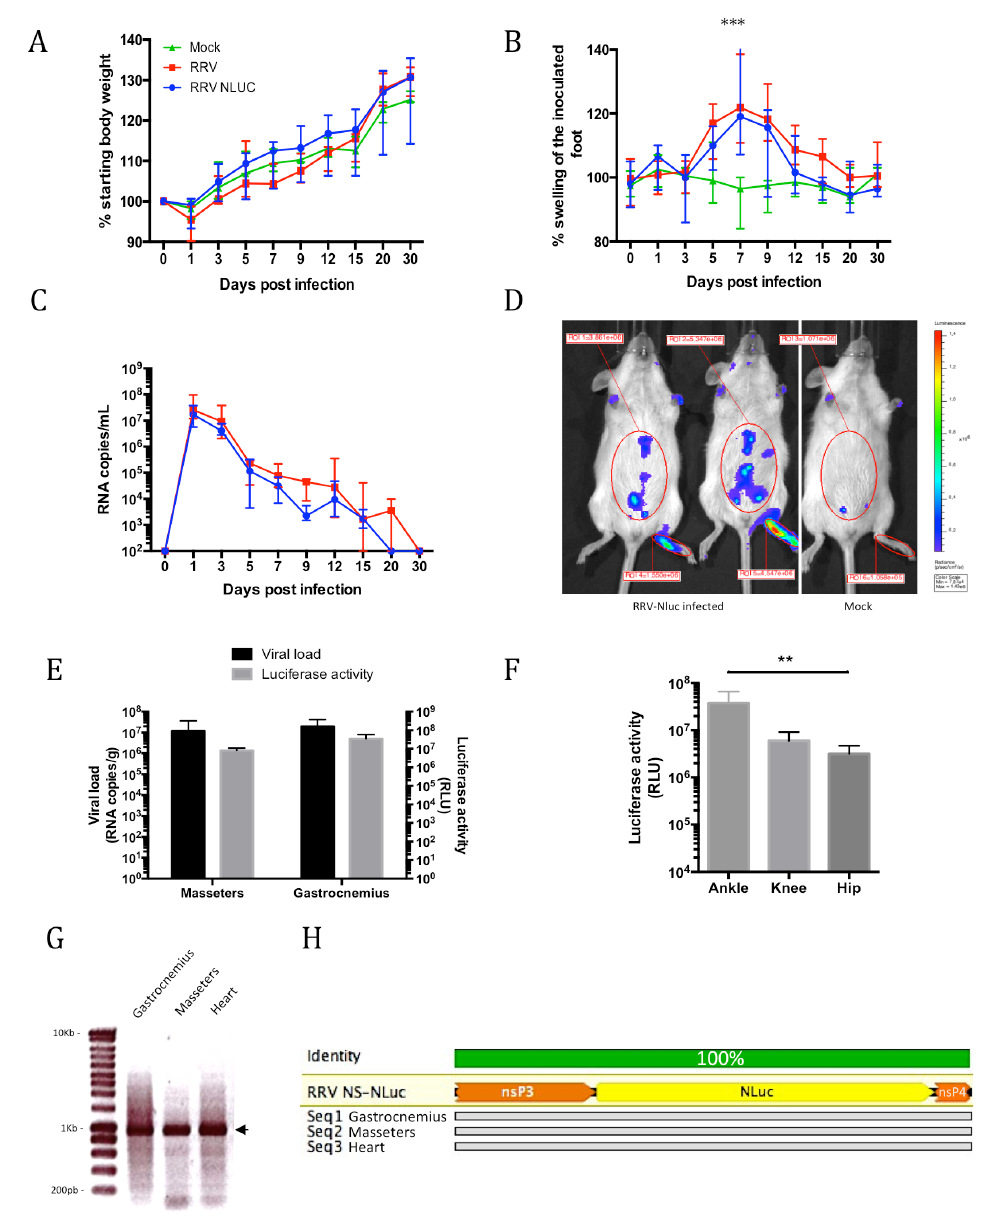
Figure 2. Experimental infections of immunocompetent albino mice with RRV-NLuc and the native RRV-T48. Mice were inoculated with 10 6 pfu of RRV-NLuc (blue) or native RRV (red) or diluent alone (green), then monitored for the indicated parameters. Each data point is the mean ± SEM of four mice and is representative of two independent experiments. ( A ) Body weight gain (%); ( B ) swelling of the inoculated foot (*** = p < 0.001, two way ANOVA); ( C ) viremia in peripheral blood; ( D ) in vivo imaging of RRV-NLuc at 1 dpi, a high bioluminescent signal is observed in the inoculated foot; ( E ) assessment of viral load (RNA / g) and luciferase activity (RLU) in the masseters and gastrocnemius muscles at 6 dpi; ( F ) luciferase activity (RLU) in the joints of the inoculated limb ( p = 0.005, Kruskal-Wallis); ( G ) electrophoresis of PCR products from total RNA extracted from gastrocnemius, masseter and cardiac muscles at 6 dpi. The amplified fragment, indicated by the arrow, contains the NLuc insert flanked by parts of nsP3 and nsP4 (expected size 950 bp); ( H ) alignment of the nsP3-nsP4 region with the NLuc insert (designed with Geneious software, Biomatters), the sequences shown were obtained 6 dpi from gastrocnemius, masseter and cardiac muscles, the insertion is present and no mutations were observed compared to the RRV-NLuc reference (data representative of three